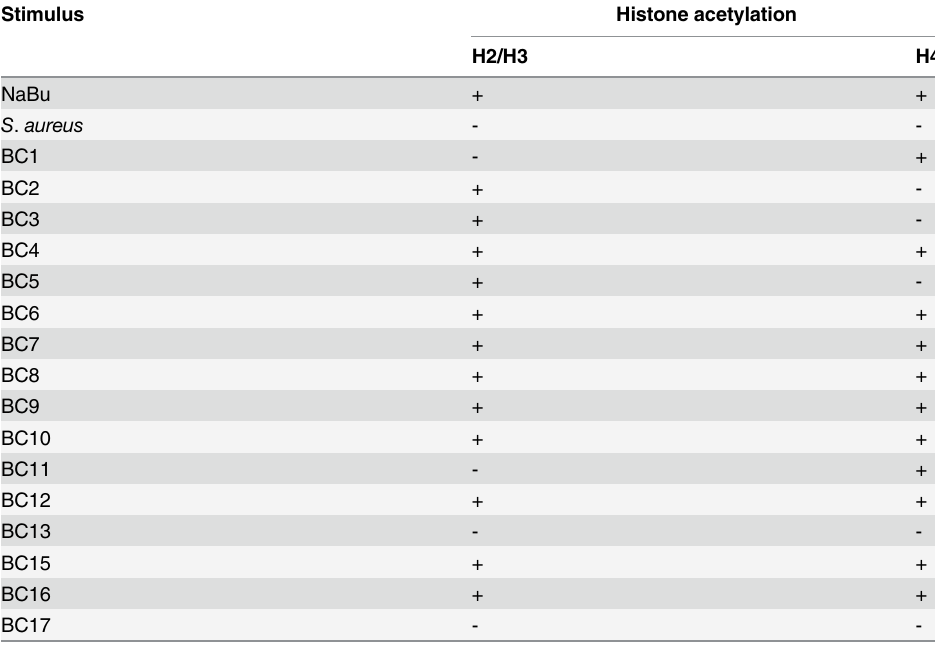
Table 4. Acetylation of C . albicans histones H2/H3 and H4 by lactobacilli cell free supernatants.